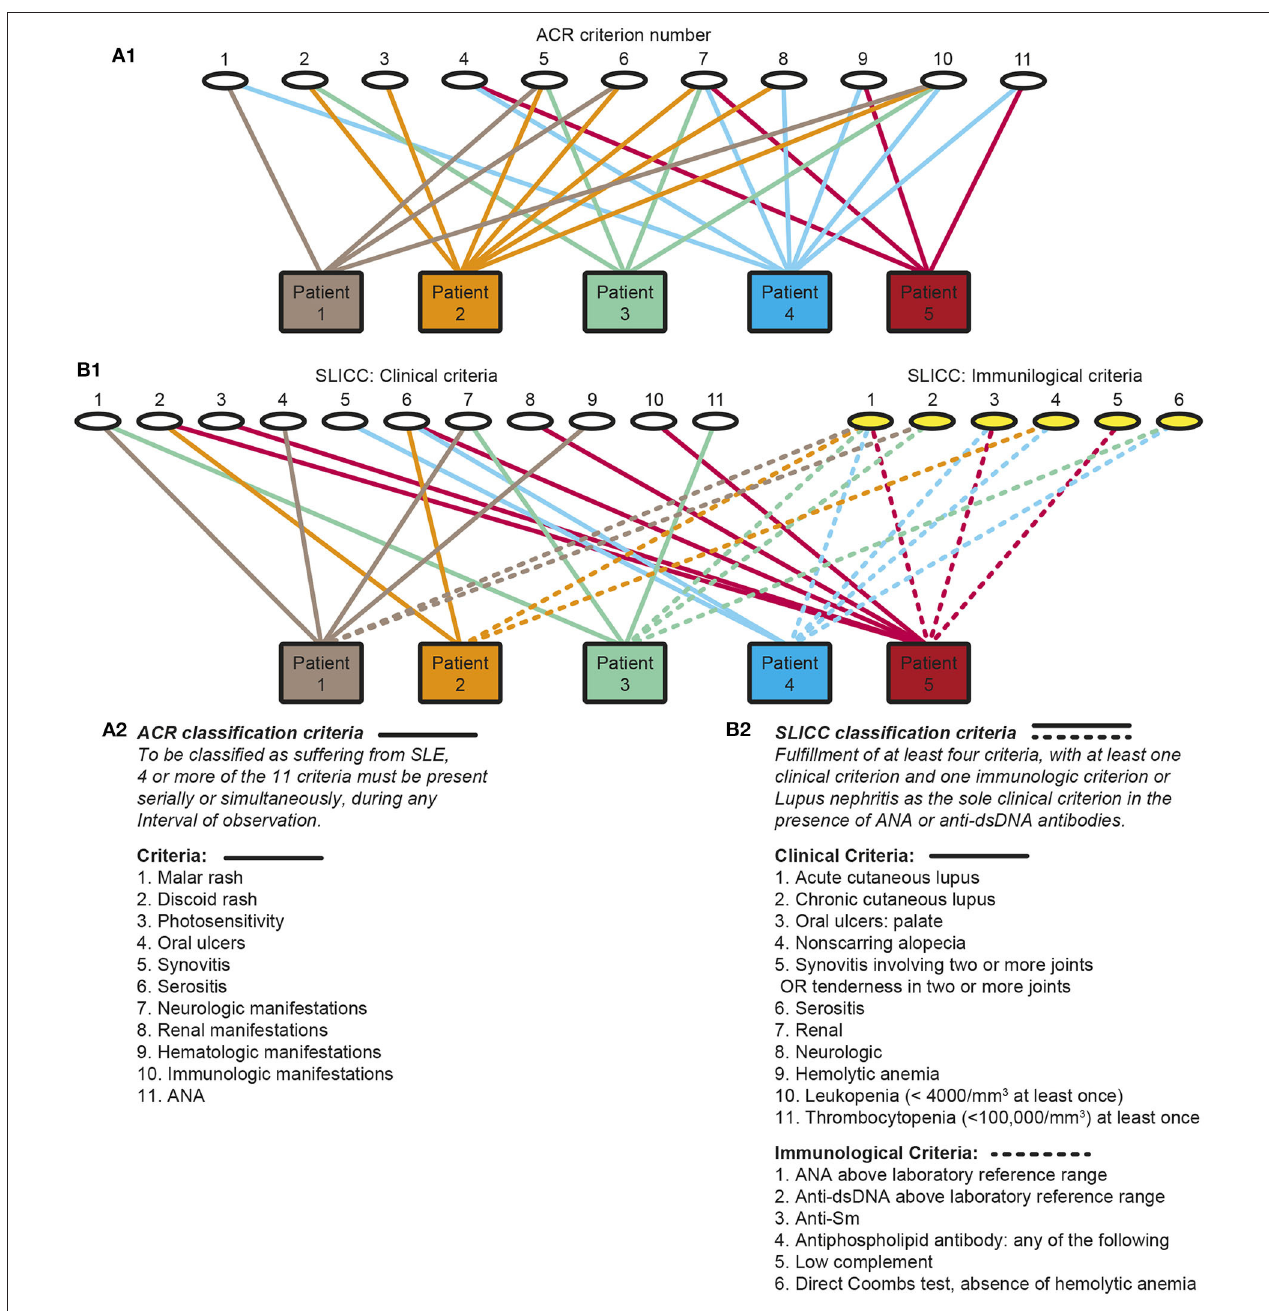
FIGURE 1 | Principal problems linked to classification of systemic lupus erythematosus (SLE). Classification of SLE patients according to The American College of Rheumatology (ACR) (A1,A2) or by The Systemic Lupus International Collaborating Clinics Criteria (SLICC) (B1,B2) classification criteria are descriptively problematized. Each of the classification systems identify a substantial diversity of clinical phenotypes. The 11 ACR criteria is presented by numbers ( A1 , the classification criteria are presented as a focused table in A2 ). Five patients are demonstrated. The patients share some criteria, but diverge with respect to others, and their clinical phenotypes differ individually. Similarly, each of 11 clinical and 6 immunological SLICC criteria are presented by numbers ( B1 , the classification criteria are presented as a focused table in B2 ). These chaotic figures (A1, B1) demonstrate that the use of the ACR and the SLICC criteria is problematic as bases for scientific analyses covering genetics, etiology, pathogenesis, and response to experimental therapy in patient cohorts as the study objects do not represent a homogenous group of patients. The patients in these figures are fictive but they reflect problems with the ACR and SLICC criteria in real life (Part of this figure (A) is a reprint with permission of Figure 1 in Rekvig